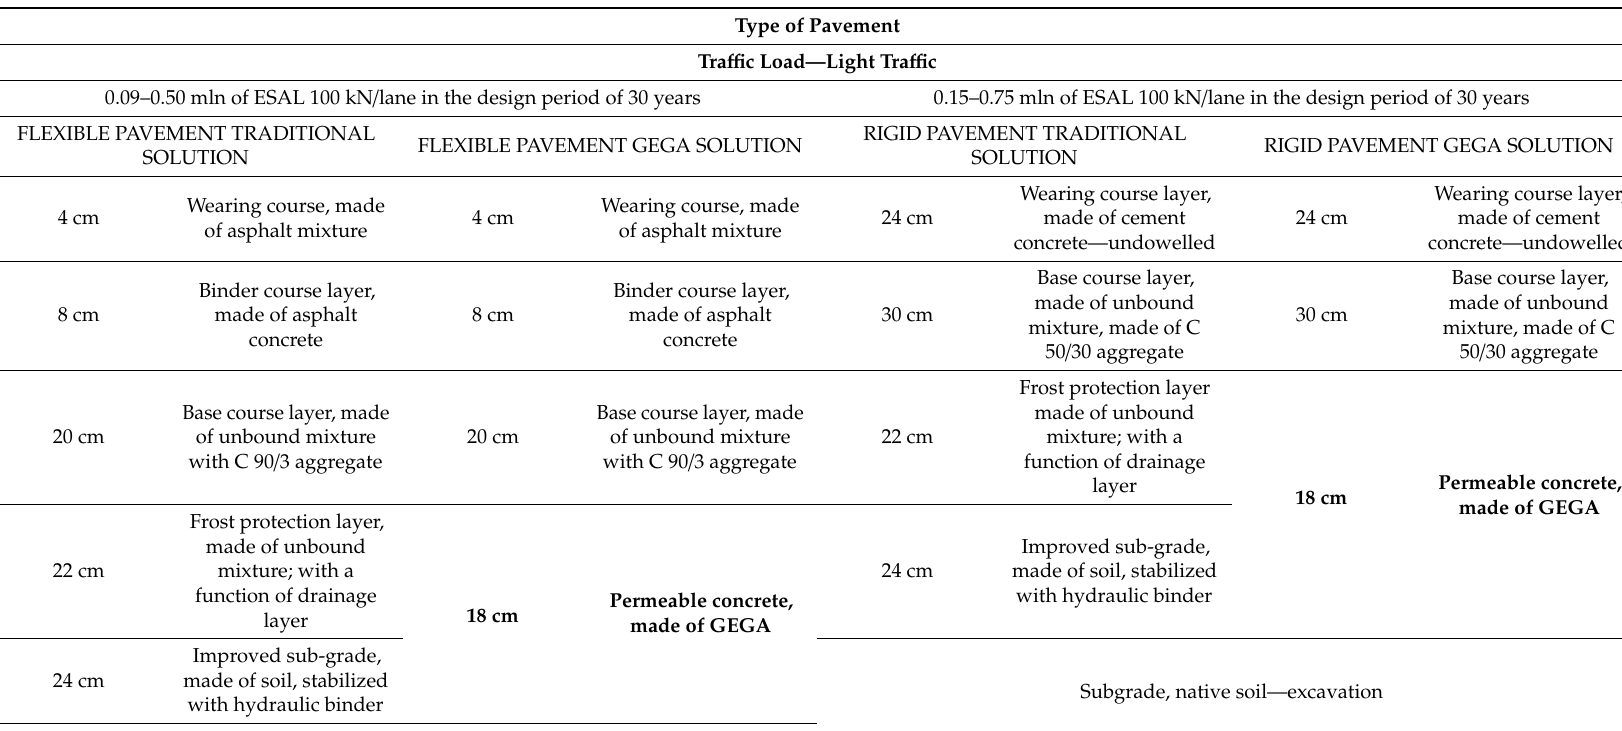
Table 6. Resulted structural layers of flexible and rigid pavements—traditional and permeable concrete, made of GEGA, solutions for light tra ffi c. Type of Pavement Tra ffi c Load—Light Tra ffi